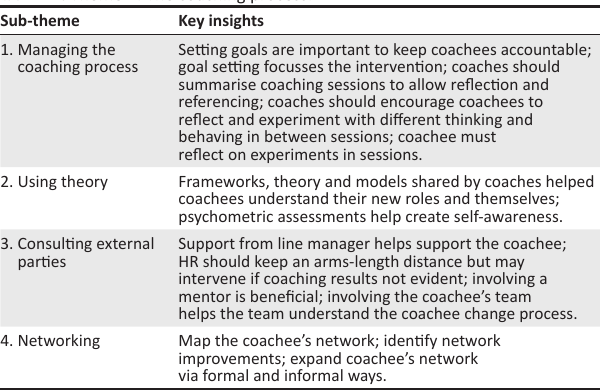
TABLE 2: Theme 2: The coaching process.